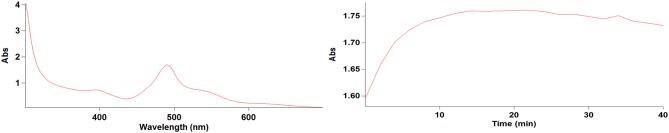
Full wavelength scan (nm) and selecting the best time (min) for measuring the absorbance (Abs).